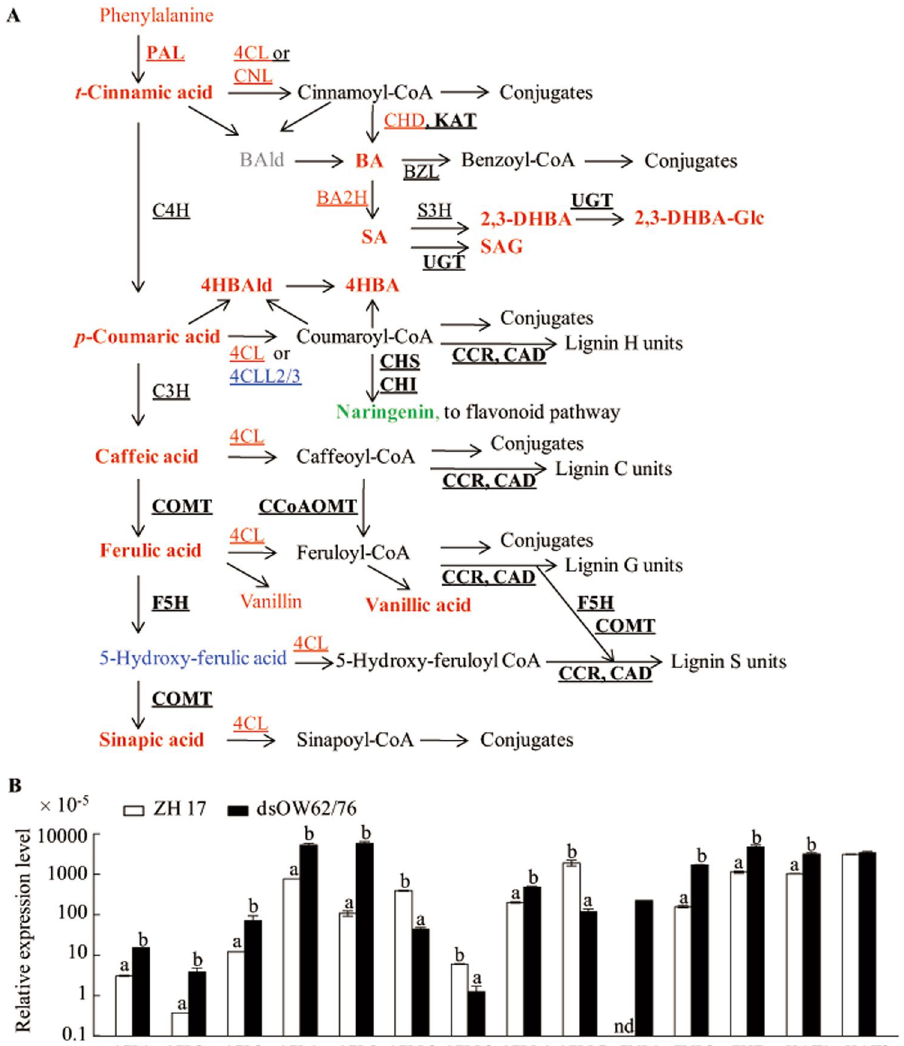
Figure 2. Schematic representation of variations in the phenylpropanoid pathway ( A ) and gene expressions ( B ). Free phenolic acids can be activated by ligases (4CLs) to form phenoloyl-CoAs, which may conjugate with amines to produce phenolamides or used as precursors for lignan biosynthesis. Feruloyl-CoA can be converted to coniferaldehyde by caffeic acid 3- O -methyltransferase (CCR) and further to coniferyl alcohol by cinnamyl alcohol dehydrogenase (CAD). Ferulate 5-hydroxylase (F5H) can catalyze the 5-hydroxylation of coniferaldehyde and coniferyl alcohol and then the products are methylated by caffeic acid/5-hydroxyferulic acid O -methyltransferase (COMT) to produce sinapaldehyde and sinapyl alcohol. Phenoloyl-CoAs generated by ligase like enzymes (4CLLs, or CNLs) in peroxisome may go through β -oxidative pathway to form benzenoid compounds. The font colors and shapes represent the same meanings as described in Fig. 1. The chemicals in bold were the compounds labeled by isotopes in the [ 2 H 8 ]Phe feeding experiments. A rice ubiquitin gene was used as the internal standard for qPCR analysis. Experiments were performed twice with similar results. Values marked with different letters indicate statistically significant differences as analyzed by SAS software (Duncan’s multiple range test, α = 0.05). nd for undetectable. Abbreviations: BA, benzoic acid; BAld, benzaldehyde;